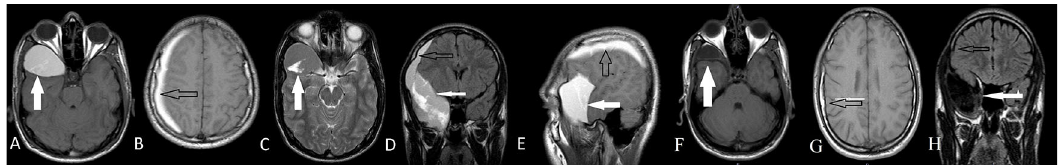
Figure 4. Axial T1W MRI (A,B), T2W (C) MRI, coronal MRI (D) and sagittal MRI (E) images of Case 10 in which a subdural hematoma (black arrows) is close to an arachnoid cyst (white arrows). After two years follow-up, the patient ’ s AC size decreased as seen on axial T1W MRI (F), and cSDH disappeared thereafter the conservative treatment as seen on axial T1W (G), coronal MRI (H).